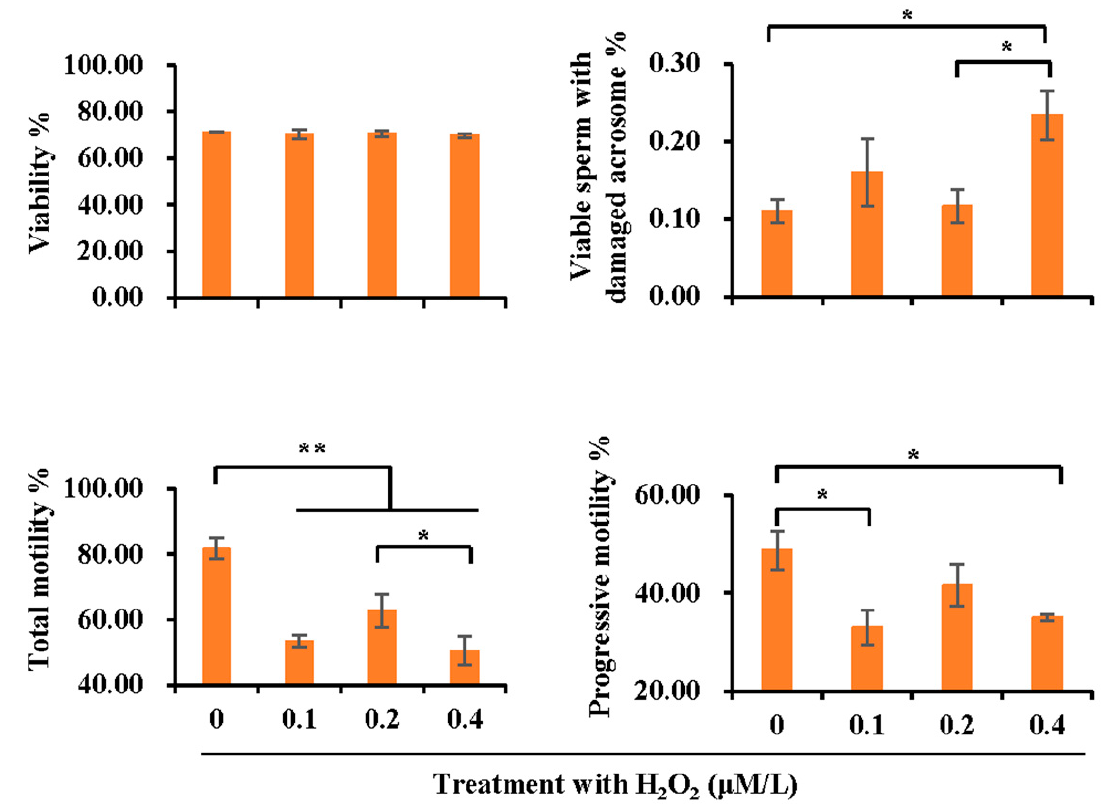
Figure 4. The effect of H 2 O 2 treatment (0, 0.1, 0.2 and 0.4 µ M/L) on sperm quality in terms of viability, acrosome integrity, total motility, and progressive motility. Bar graphs represent data expressed as mean ± SEM. * indicates differences among groups, p < 0.05; **, p < 0.01. 3.6. Effect of H 2 O 2 Treatment on Antioxidant and Oxidant Levels in Boar Spermatozoa and SF Treatment with H 2 O 2 induced higher levels of SF MDA ( p < 0.05) and intracellular ROS production ( p < 0.05), lower levels of SF TAC ( p < 0.05), and lower sperm SOD-like activity ( p < 0.01) than those of the control (Figure